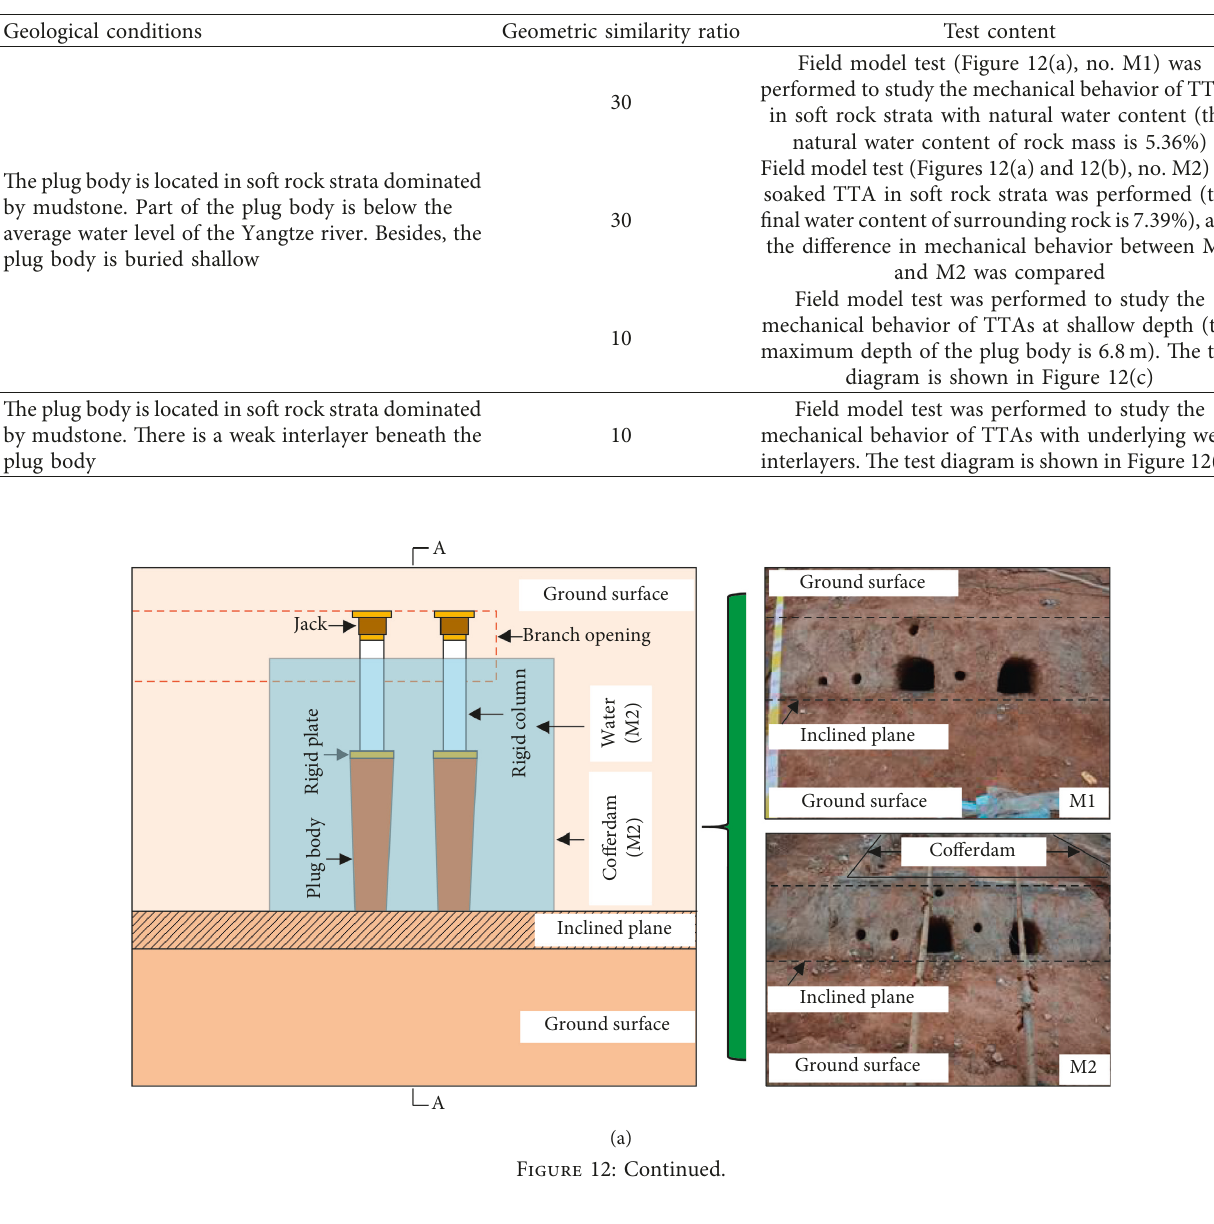
Table 2: Field model test of the TTA built in soft rock